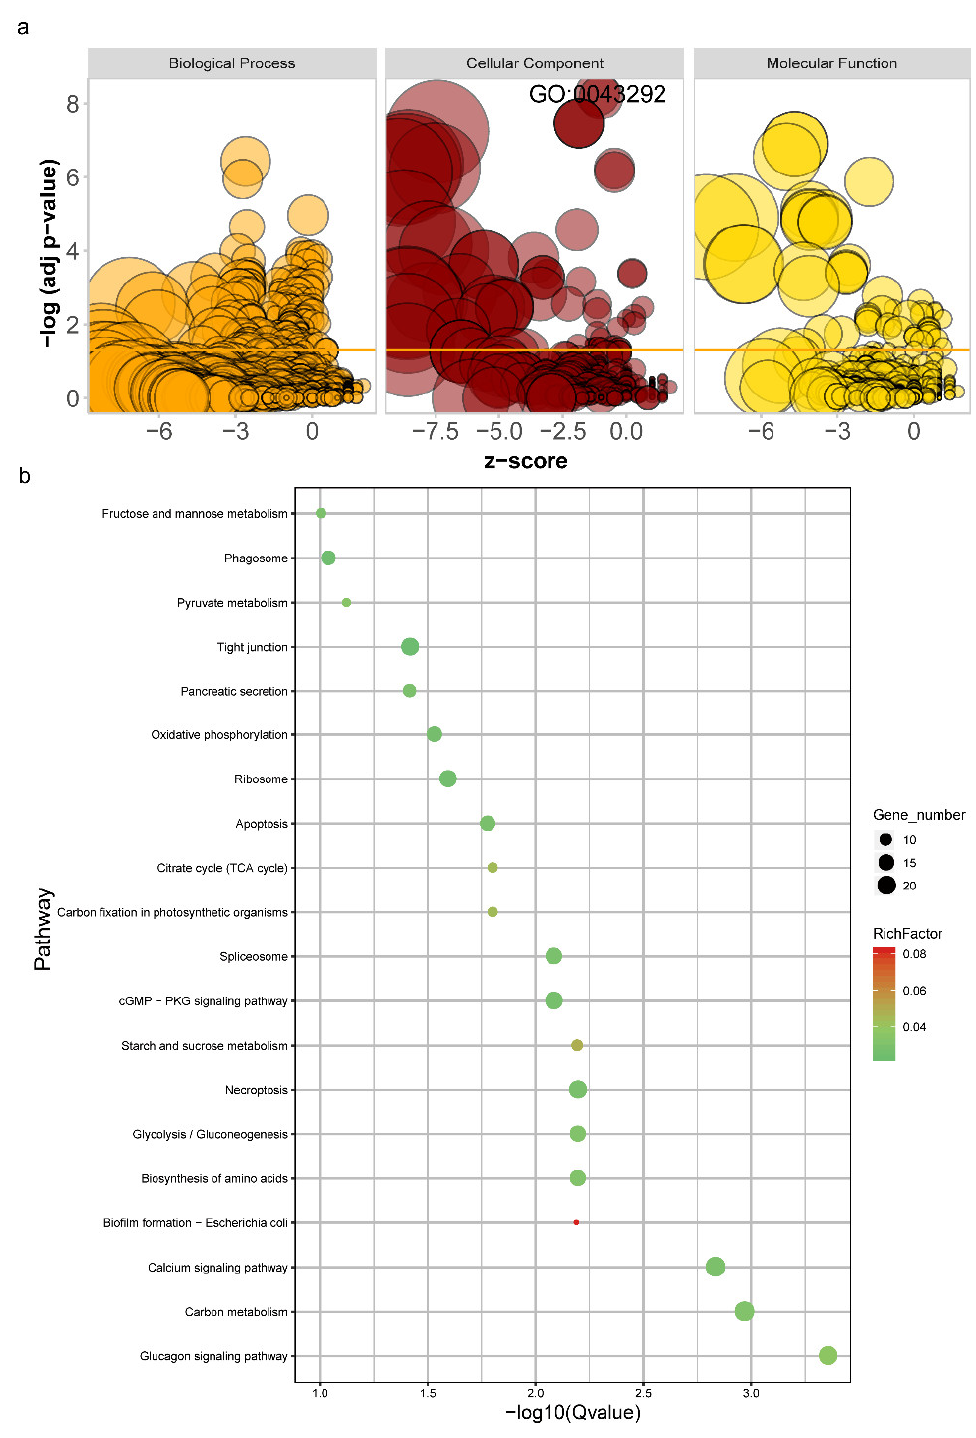
Figure 4. Functional annotation of differentially expressed isoforms (DEIs); ( a ) gene ontology (GO) enrichment analysis; X -axis denotes z-score; Y -axis denotes -log10(adjusted p value); bubble size denotes the enriched gene numbers; ( b ) Kyoto Encyclopedia of Genes and Genomes (KEGG) enrichment analysis; X -axis denotes − log10 (adjusted p value); Y -axis denotes enriched pathway; bubble size denotes the enriched gene numbers; bubble color denotes the adjusted p value.